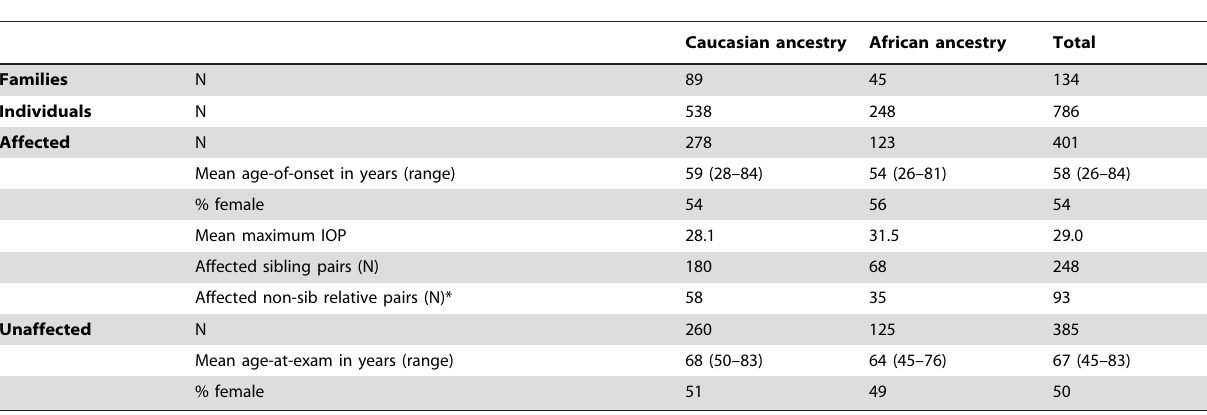
Table 1. Clinical characteristics of study